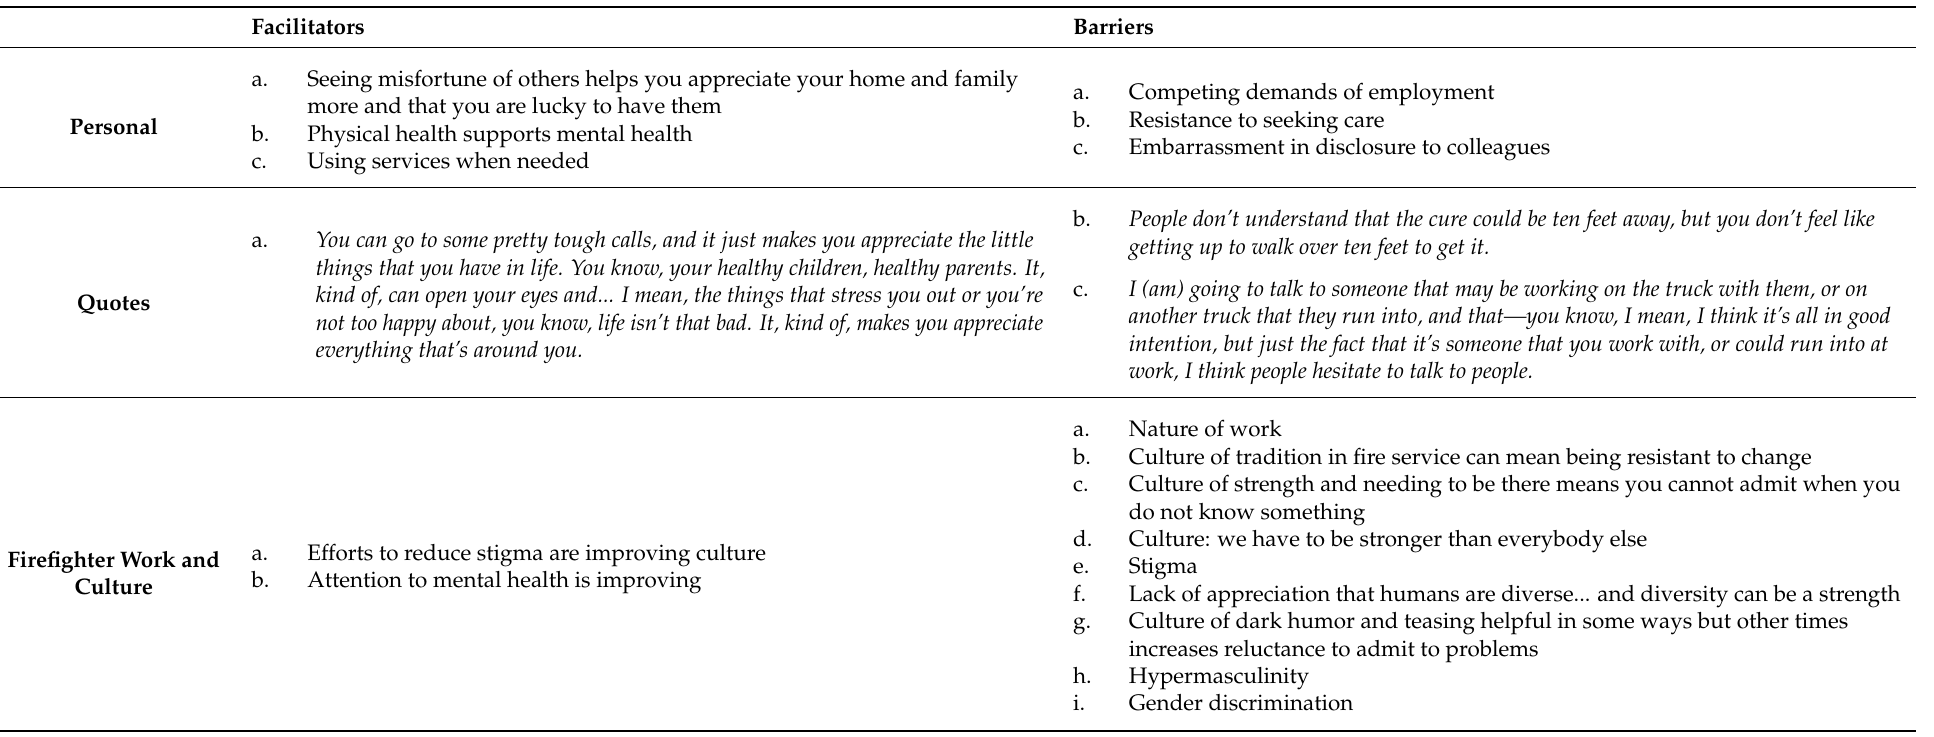
Table 1. Barriers and Facilitators Themes Identified by Firefighters, with selected illustrative